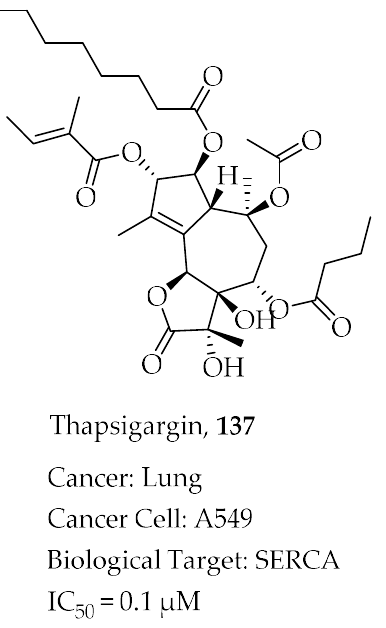
Figure 28. Structure of the sesquiterpene lactone Thapsigargin with a summary of its biological ac- tivity towards selected cancer targets.